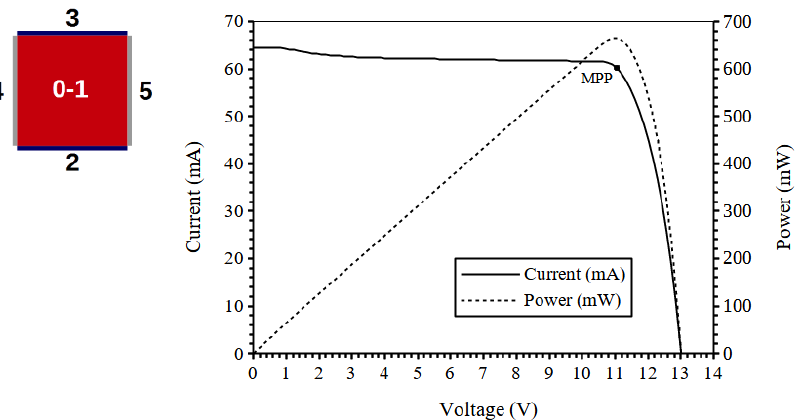
Figure 19. Characteristic curves (I-V and P-V) of the unshaded LSC panel with two 10-cells PV arrays and functionalized with 300 ppm of Lumogen ® F Red 305.